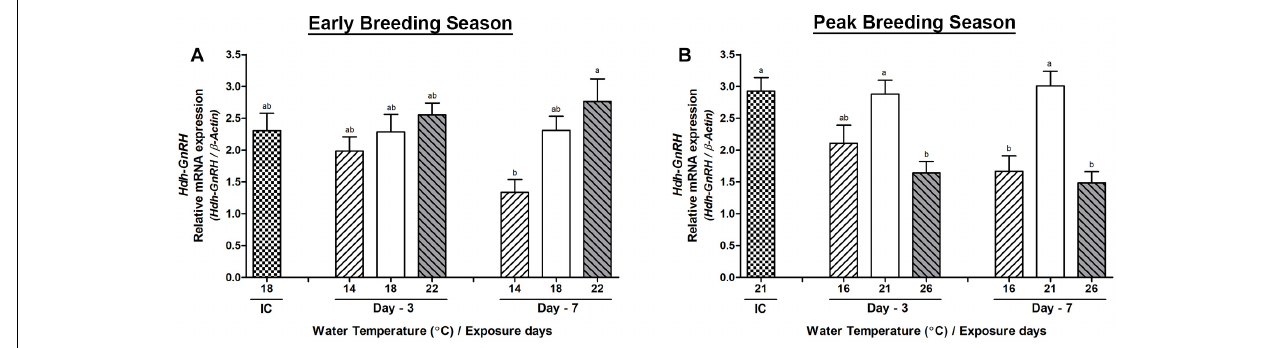
FIGURE 5 | Changes in the relative mRNA expression of Hdh-GnRH (A,B) in the branchial ganglion (BG) of male Pacific abalone during early and peak breeding seasons after exposure to thermal stress for 7 days. Before exposure to the target temperature of thermal stress, abalone were sampled to obtain reference values that served as initial control (IC). Values represent the mean ± SD ( n = 10). Different letters on the bar indicate significant differences among different temperature groups ( p <